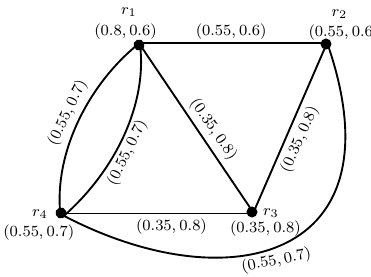
Figure 3. Complete Pythagorean fuzzy Figure 2.2: Complete Pythagorean fuzzy multigraph